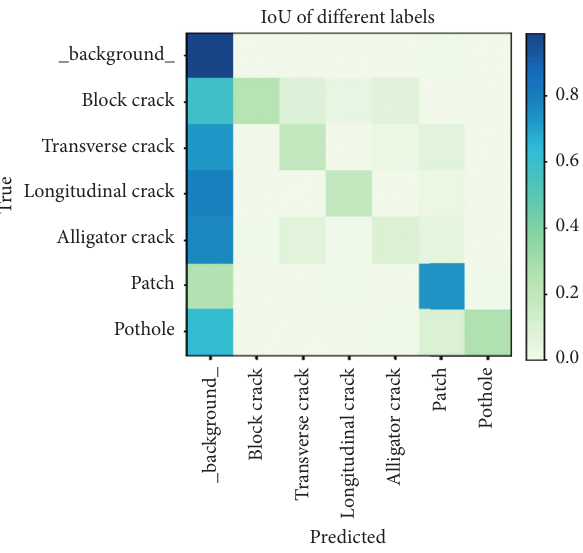
Figure 6: Confusion matrix of IoU values of different labels.